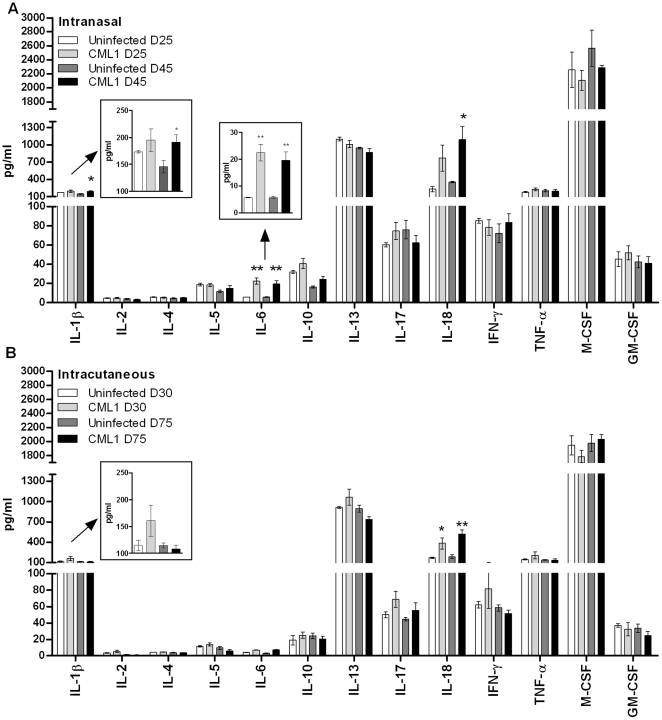
Cytokine production in the sera of nu/nu after exposure to CML1.Sera from mice inoculated i.n. (A) or i.c. (B), isolated at two time points after exposure to PBS or to CML1, were used to measure cytokine levels by ELISA. Data are the average±SEM (n = 4 mice for each group). ***p<0.001; **p<0.01 and *p<0.05, CML1 versus the corresponding values of the uninfected group by unpaired t test. Boxed regions represent a zoom-in of the corresponding field, i.e., IL-1β and IL-6.